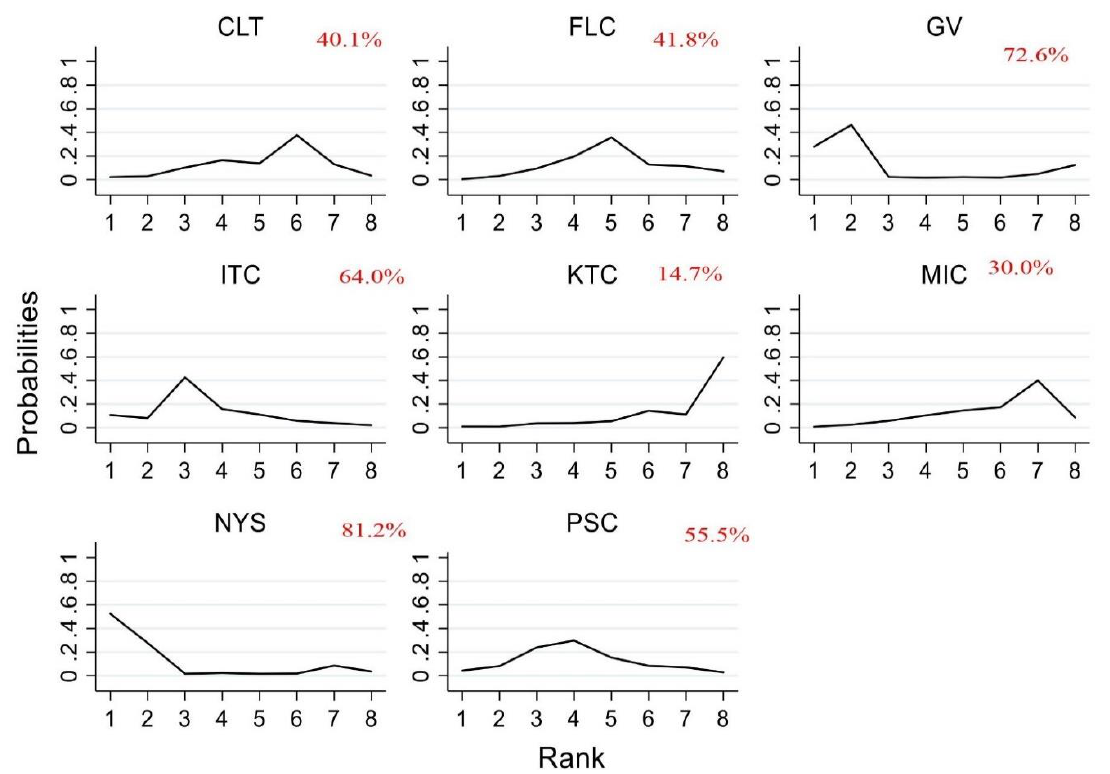
Figure 10. SUCRA ranking curve for the safety of antifungal agents used for the treatment of OPC among HIV-infected adults. Abbreviations: CLT—clotrimazole, FLC—fluconazole, GV—gentian violet, ITC—itraconazole, KTC—ketoconazole, MIC—miconazole, NYS—nystatin, PSC—posaconazole. Table 4. Network estimates and SUCRA ranking of the safety of antifungal agents used for the treatment of OPC among HIV-infected adults.